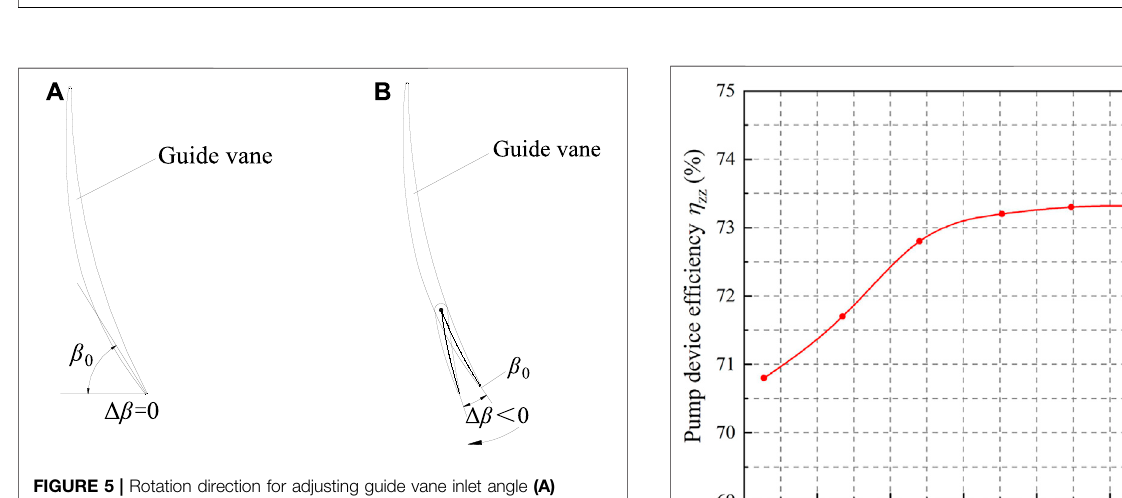
FIGURE 4 | Matching relationships between the guide vane inlet angle and the impeller outlet fl ow direction. (A) Design discharge condition ( α 0 (cid:2) β 0 ), (B) Smaller discharge condition ( α s < α 0 ), (C) Larger discharge condition ( α L < α 0 ).